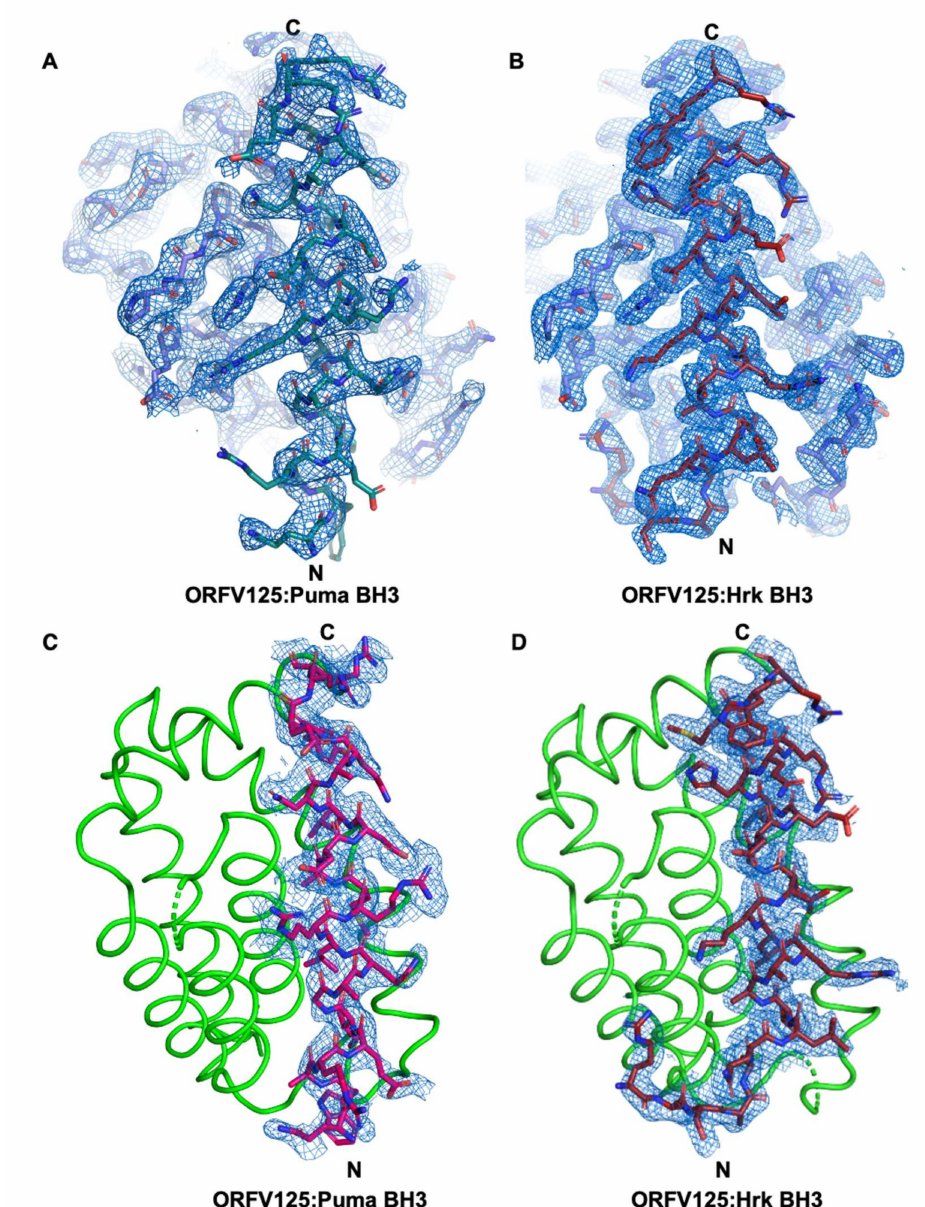
Figure 1. Electron density maps of ORFV125: Hrk and Puma BH3 complexes. 2Fo-Fc electron density maps of ( A ) ORFV125: Puma BH3 complex and ( B ) ORFV125: Hrk BH3 complex, interfaces contoured at 1.5 σ . The N- and C-termini of the BH3 peptide are indicated. ( C ) Omit map of ORFV125: Puma BH3 complex and ( D ) ORFV125: Hrk BH3 complex, contoured at 3 σ . BH3 peptides are shown as sticks, ORFV125 backbone is shown as